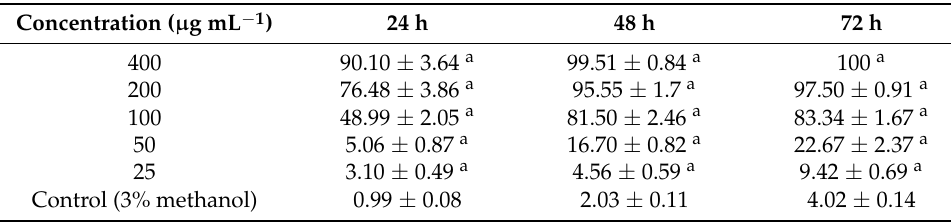
Table 2. Effect of Compound 1 on the Mortality (%) of M. incognita [mortality ± SD].